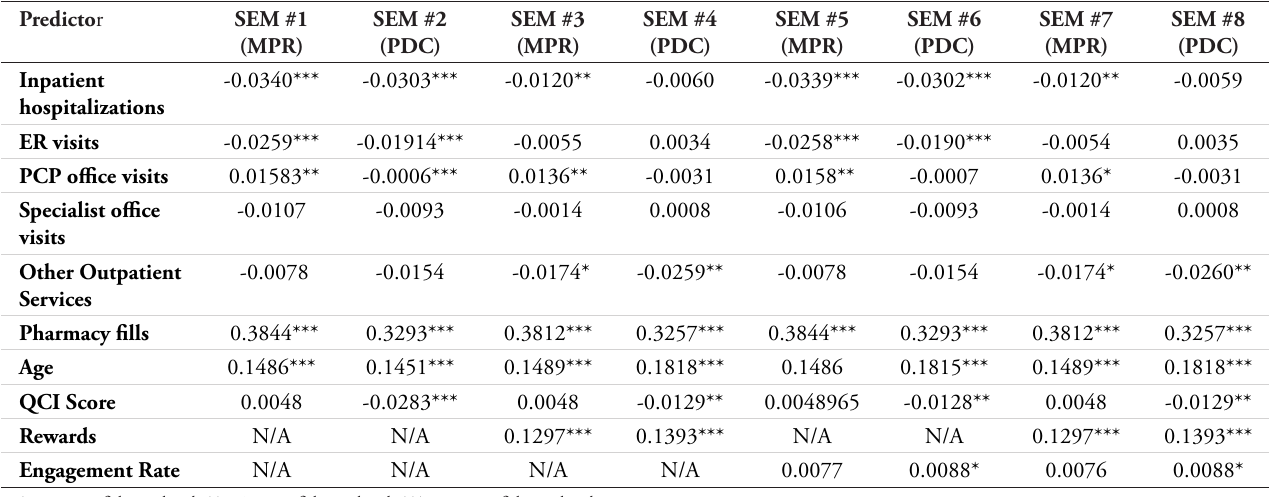
Table 5. Comparison of Total Effects Across Eight